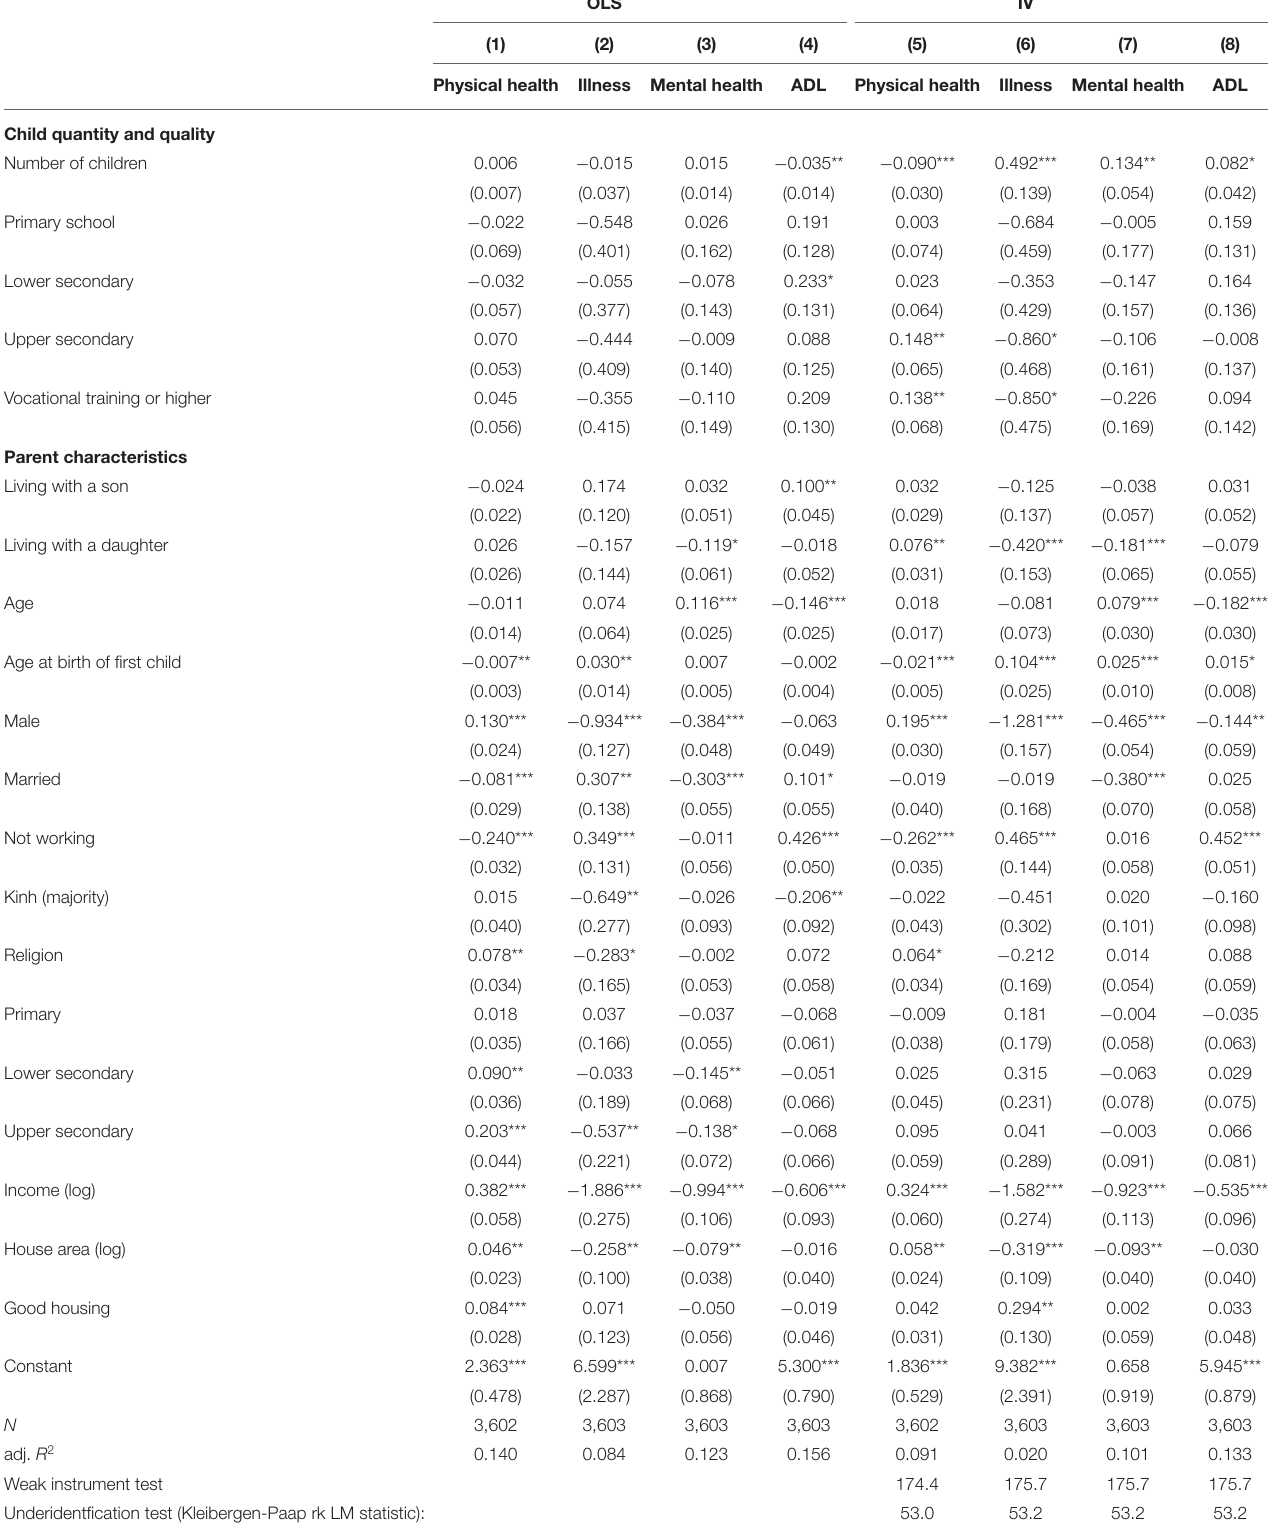
TABLE 3 | Effects on elderly parents’